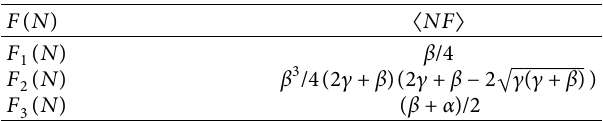
Table 3: Average factors for various intraspecific models of wild- type insect growth rate.